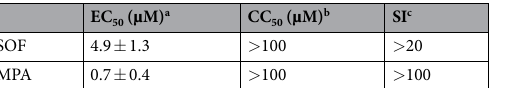
Table 1. Antiviral activity of test compounds against Dengue virus infection in cell culture. a The 50% effective concentration (EC 50 ) was determined in Huh7 cells using the Promega Viral ToxGlo Assay. Data represent the means ± standard deviation (SD) of 3 independent experiments. b The 50% cytotoxic concentration (CC 50 ) was determined in Huh7 cells using the Viral ToxGlo Assay. c SI: selectivity index, as determined by the ratio of CC 50 to EC 50